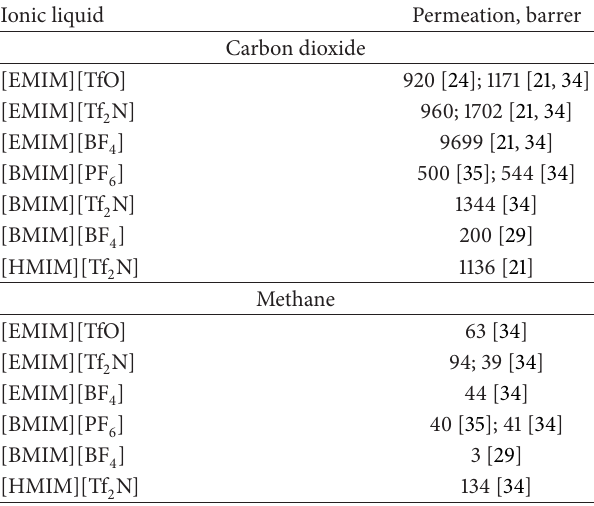
Table 1: Gas permeation values in 298 K described in literature. Ionic liquid Permeation,